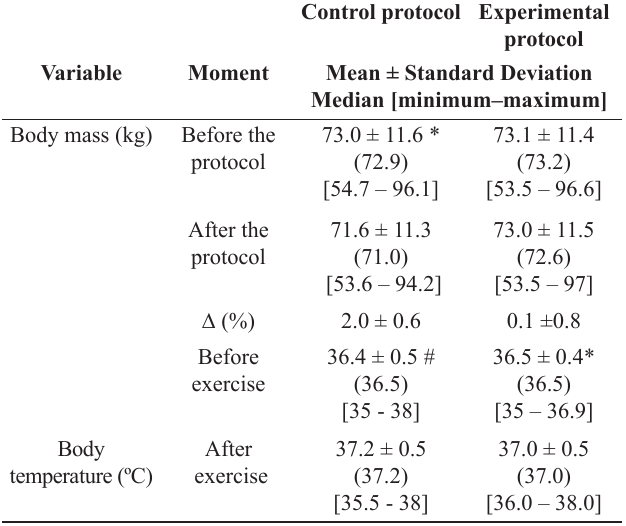
Table 2. Values of body mass and temperature in control and experi- mental